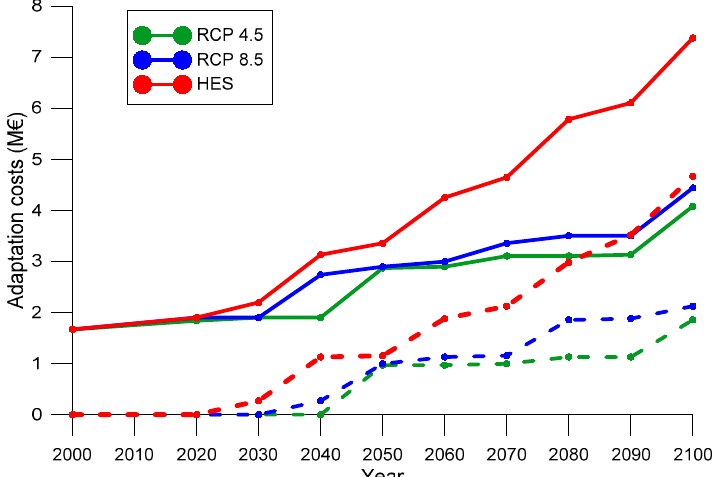
Figure 7. Estimation of adaptation costs (in millions of euros) of Catalan ports to overtopping for the three SLR scenarios and for a return period of 5 years. Filled lines indicate the cost of zero damage option and dashed lines correspond to the costs of minimum damage alternative.